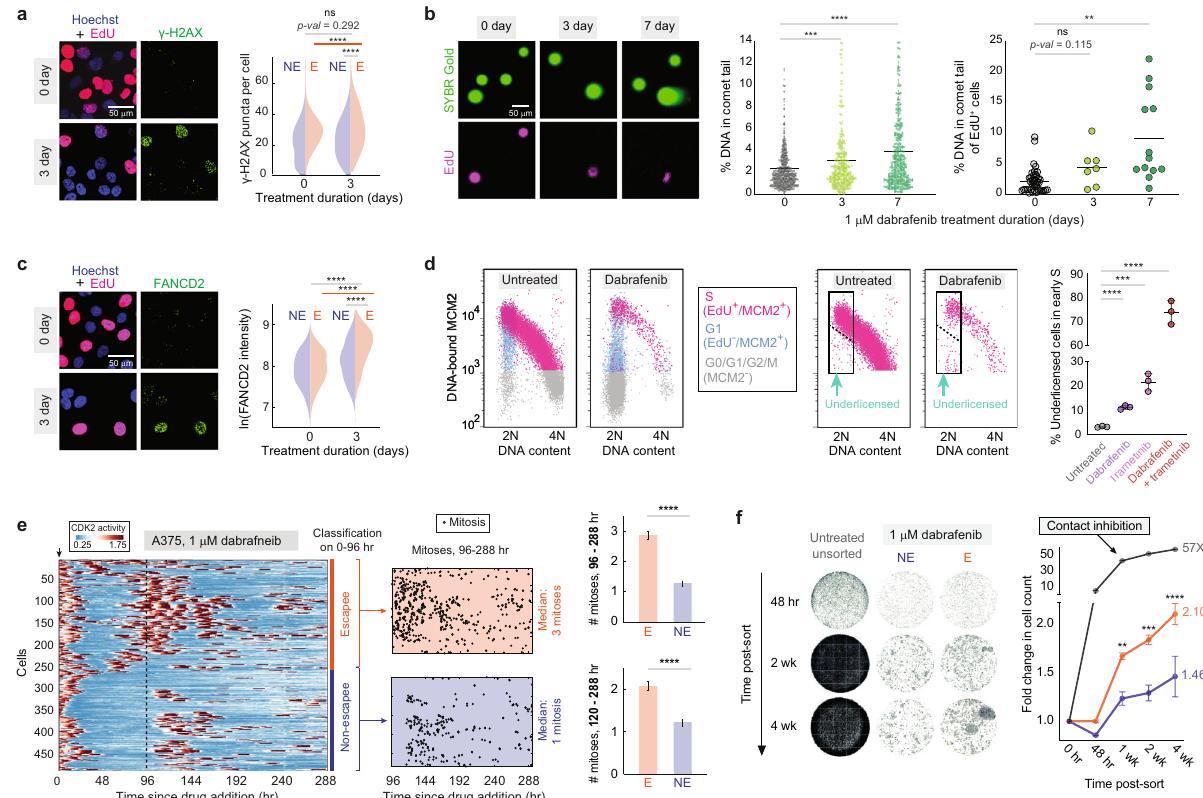
Fig. 7 Escapees are prone to DNA damage and outgrow non-escapees over extended drug treatment. a Images of A375 cells treated with 1- µ M dabrafenib for 72 h stained for EdU and γ -H2AX. Quanti fi cation of γ -H2AX puncta for escapees (E) and non-escapees (NE) is plotted as split violins. n = 2 biologically independent experiments. b Neutral comet assay in dabrafenib-treated A375 cells. Gels were co-stained for EdU incorporation. Plots indicate percent tail intensity over each entire comet, with mean values displayed as a horizontal line. Left panel: 0, 3 and 7 days, n = 708, 375 and 394 cells. Right panel: 0, 3 and 7 days, n = 40, 7 and 13 cells. c Images of A375 cells treated with 1- µ M dabrafenib for 72 h stained for EdU and FANCD2. Quanti fi cation of FANCD2 intensity for escapees and non-escapees is plotted as split violins. n = 2 biologically independent experiments. d Flow cytometric analysis of DNA replication licensing determined by chromatin-bound MCM2 in A375 cells treated with BRAF and/or MEK inhibitors. Cells appearing under the dashed line show reduced MCM2 loading at the start of S phase. Right-most plot shows percent under-licensed cells relative to all early S phase cells; mean ± std of three replicate samples. e CDK2 activity heatmap for 482 dabrafenib-treated single cells tracked over 12 days. Cell behaviour was classi fi ed based on the fi rst 96 h, and subsequent mitosis events are plotted as black dots. Bar plot quanti fi es the average number of mitoses per cell in the fi nal 7 or 8 days of fi lming. Error bars: mean ± SEM. n (E; NE) = 248; 234 cells. f Escapees (Gem + ) and non-escapees (Gem − ) cells were separated by FACS after a 72 h of 1- µ M dabrafenib treatment and were then continuously cultured in 1- µ M dabrafenib for 4 weeks. Representative wells for each condition at different time points are shown. Normalized cell count for each well was quanti fi ed and plotted for each condition; mean ± SEM of seven replicate wells. The p value summary represents the comparison between E and NE replicates by unpaired t -test. Source data are provided as a Source Data fi